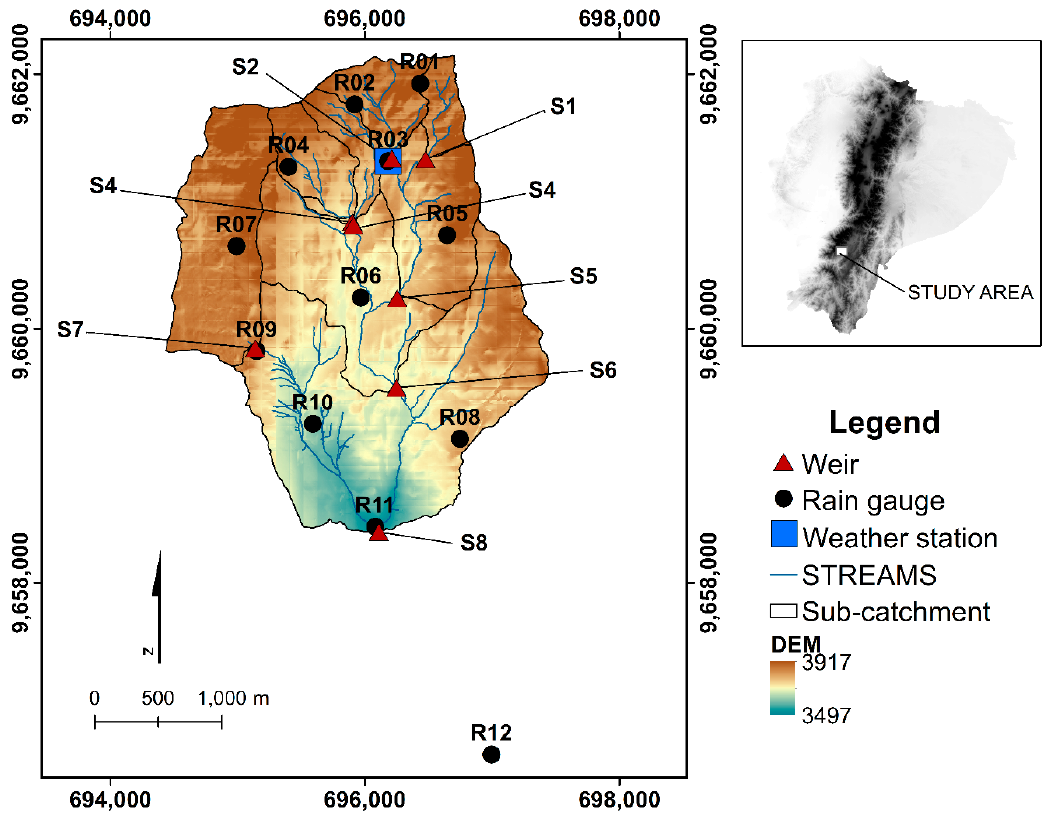
Figure 1. Study area and monitoring network. Coordinate system: UTM WGS84 17S.